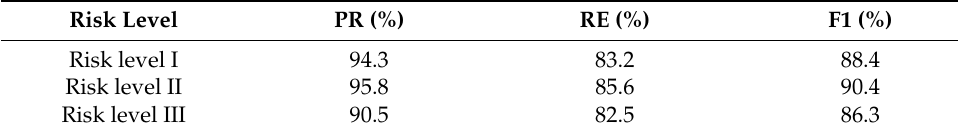
Table 6. Prediction result of real-time risk levels of road hazmat